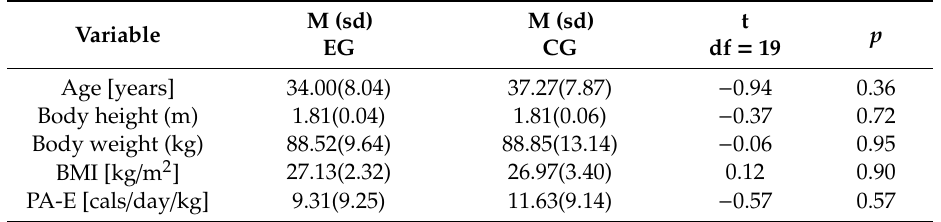
Table 1. Average values, standard deviations and di ff erences between groups for the general characteristics of the participants and physical activity before the start of the